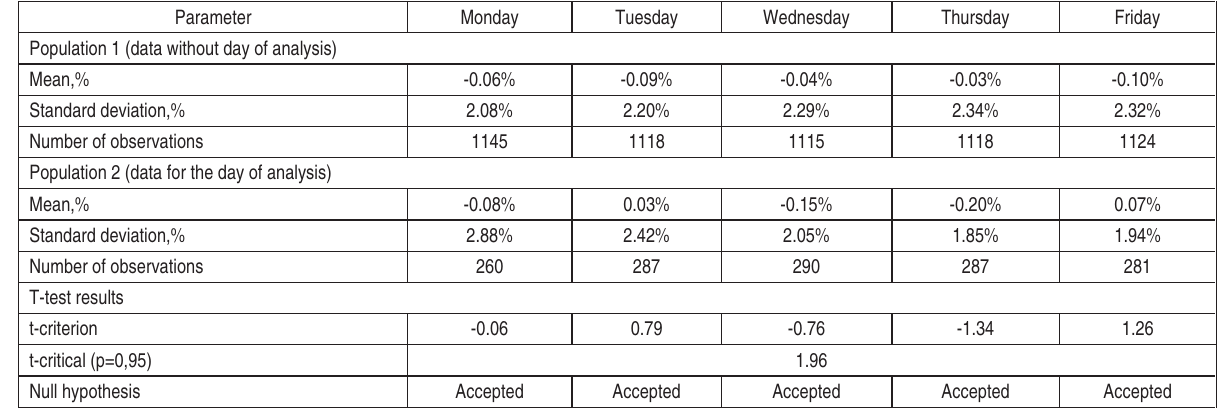
Table B3. T-test of the day-of-the-week effect for UX index futures